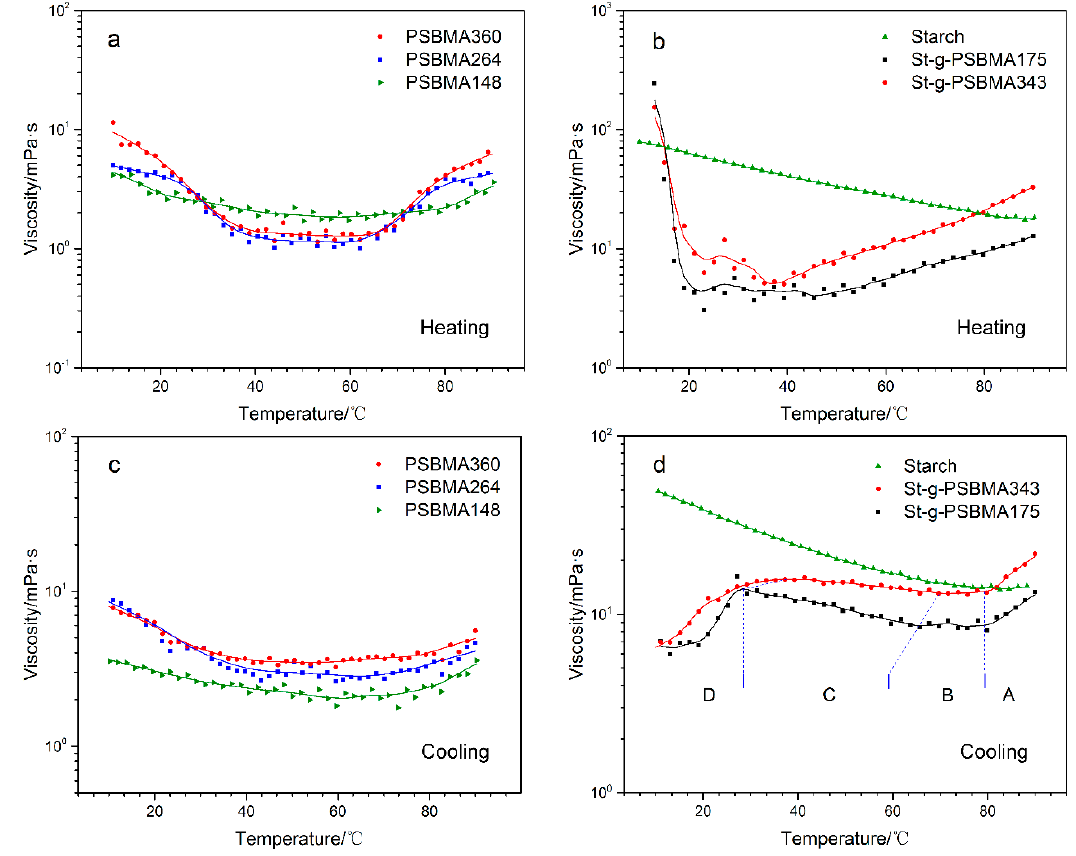
Figure 6 . Solution viscosity vs. temperature of ( a ) PSBMA homopolymer (Heating), ( b ) St-g-PSBMA (Heating), ( c ) PSBMA homopolymer (Cooling), and ( d ) St-g-PSBMA (Cooling) (the solid line is to guide the eye).